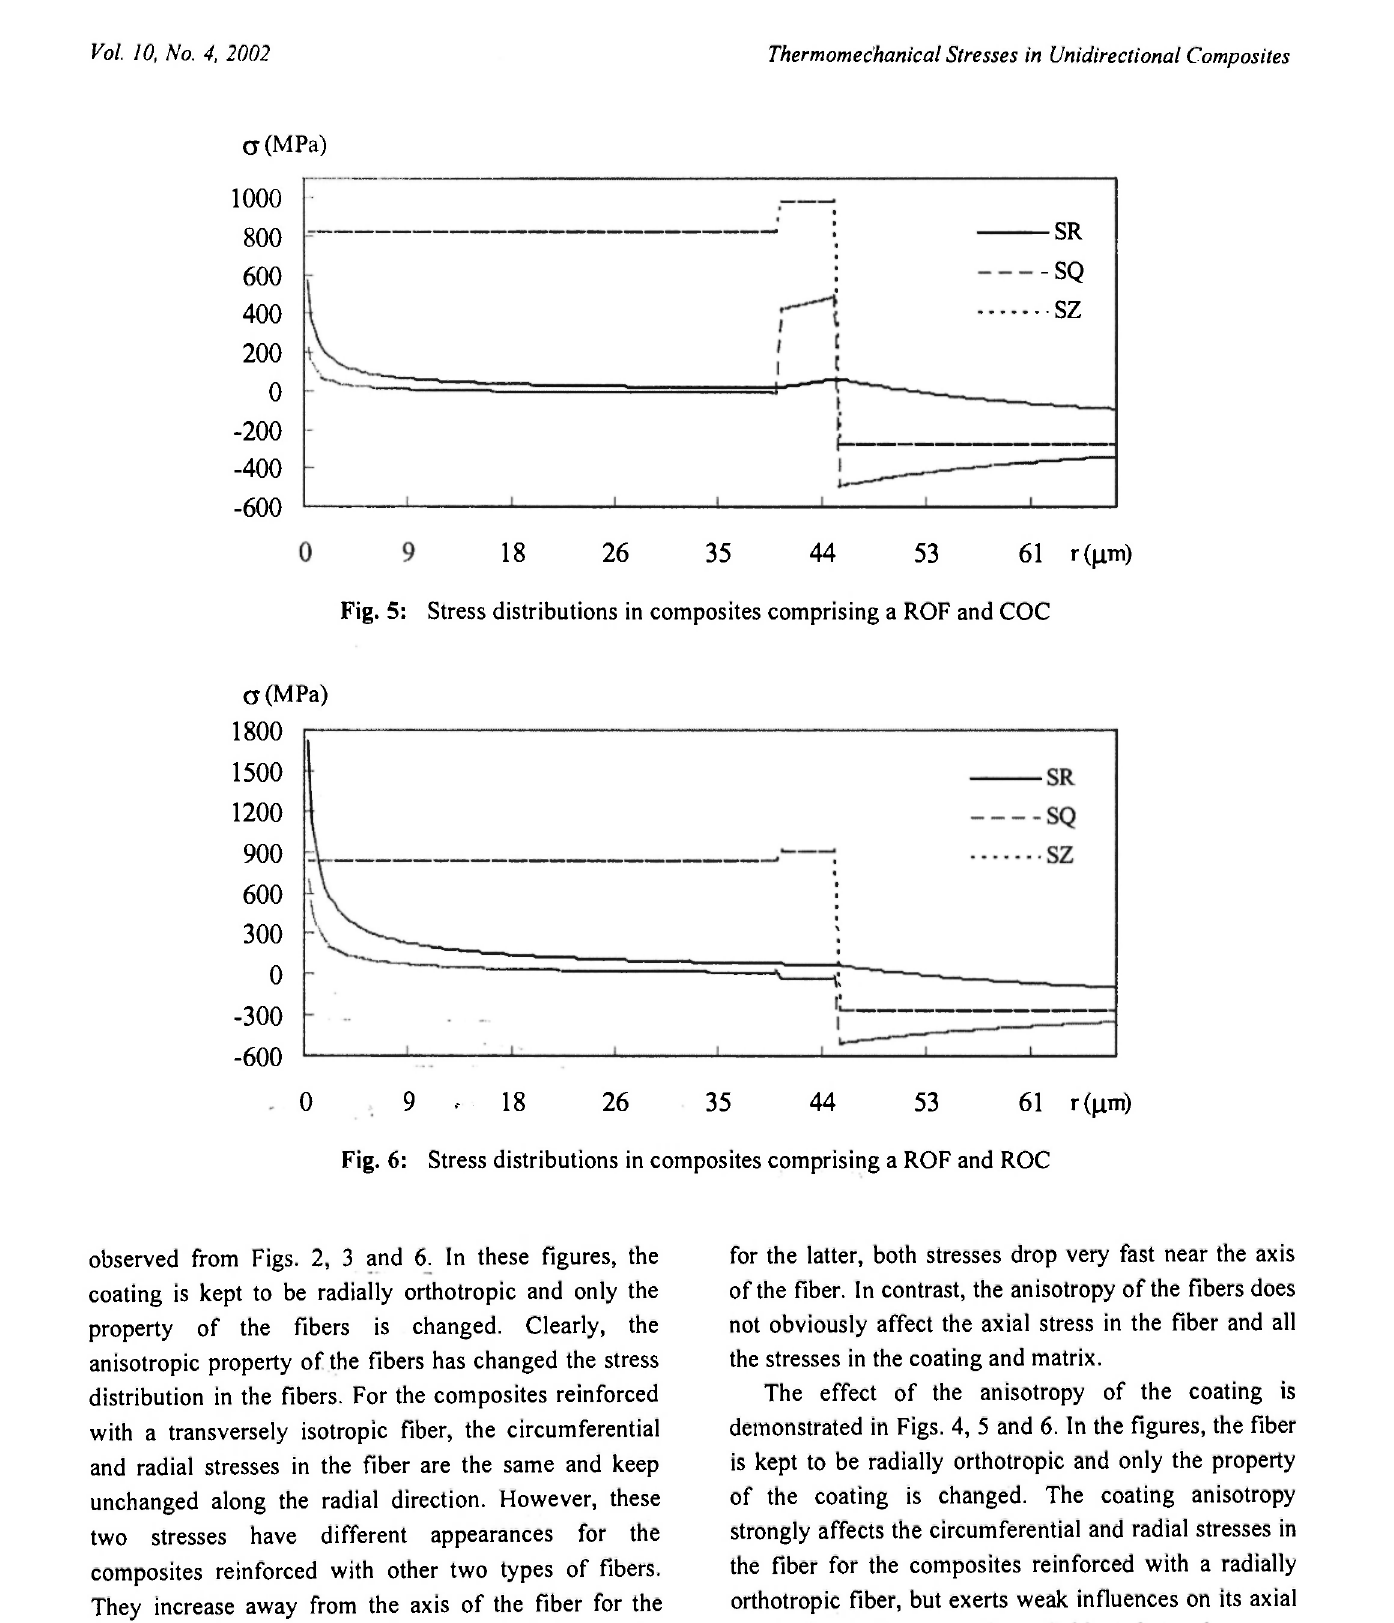
Fig. 5: Stress distributions in composites comprising a ROF and COC